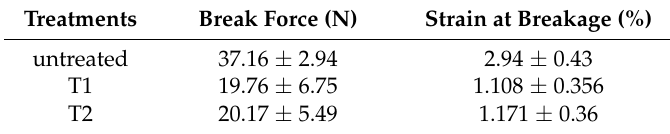
Table 4. Weight increase (%) of FA treated and untreated composites after water absorption (average and standard deviation). Time (h)